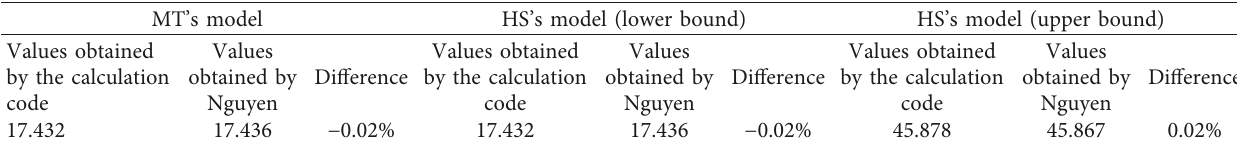
Table 7: Validation of Mathematica calculation code for homogenisation. MT’s model